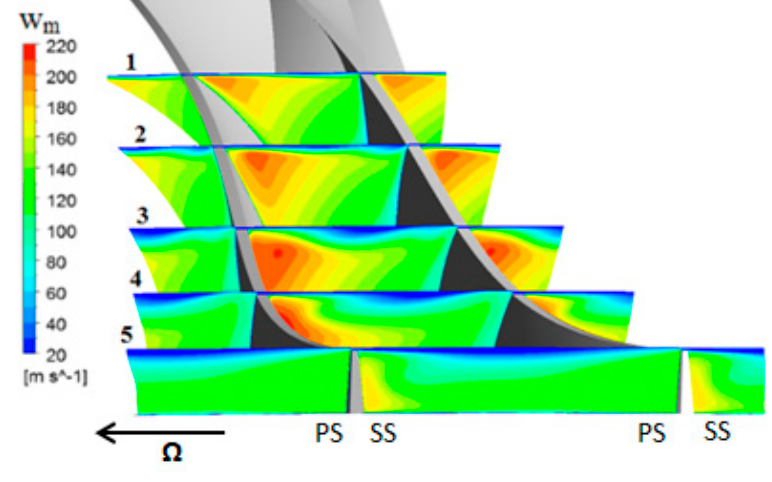
Figure 9. Meridional velocity in the impeller, point P1.